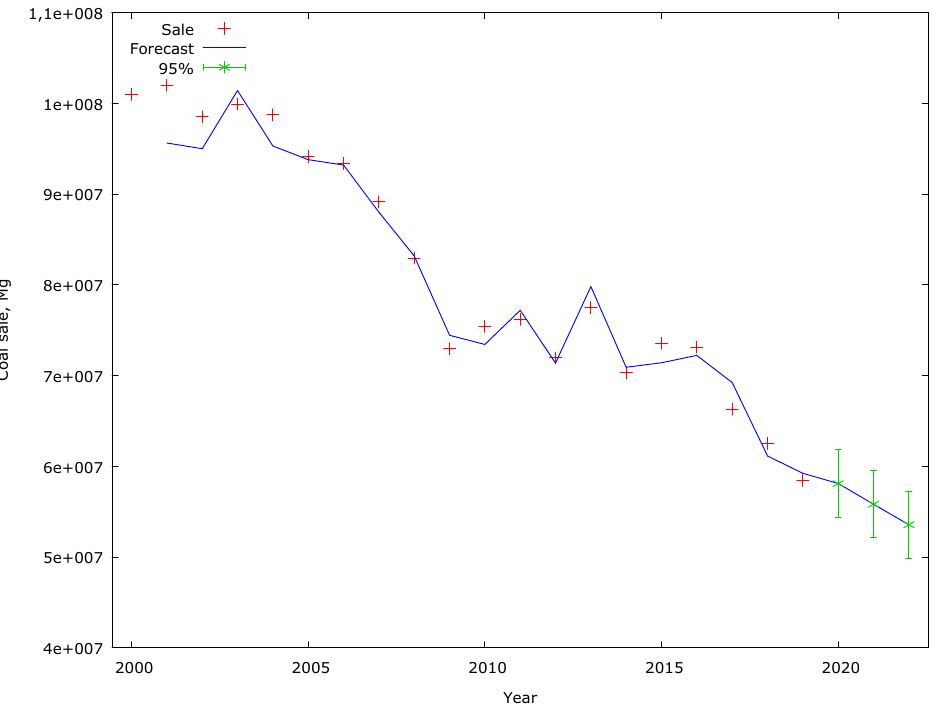
Figure 2. Hard coal demand forecast using the ARMAX (0,1,1) model.